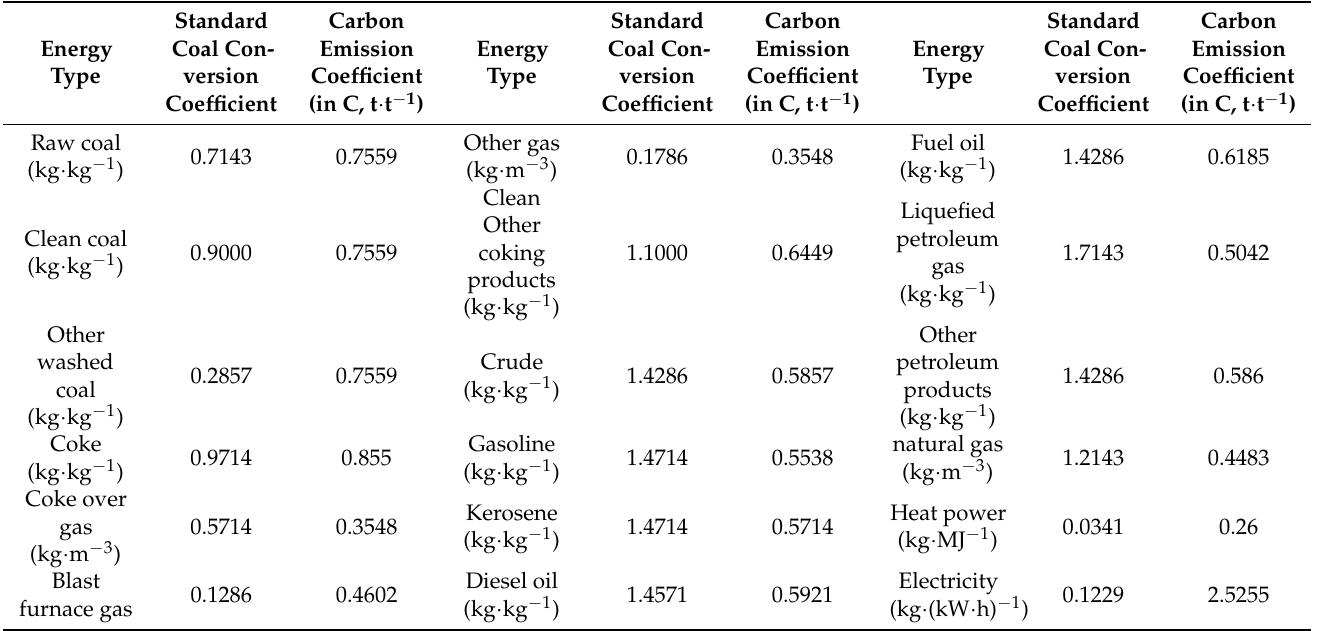
Table 2. Standard coal conversion coefficient and carbon emission coefficient of various energy